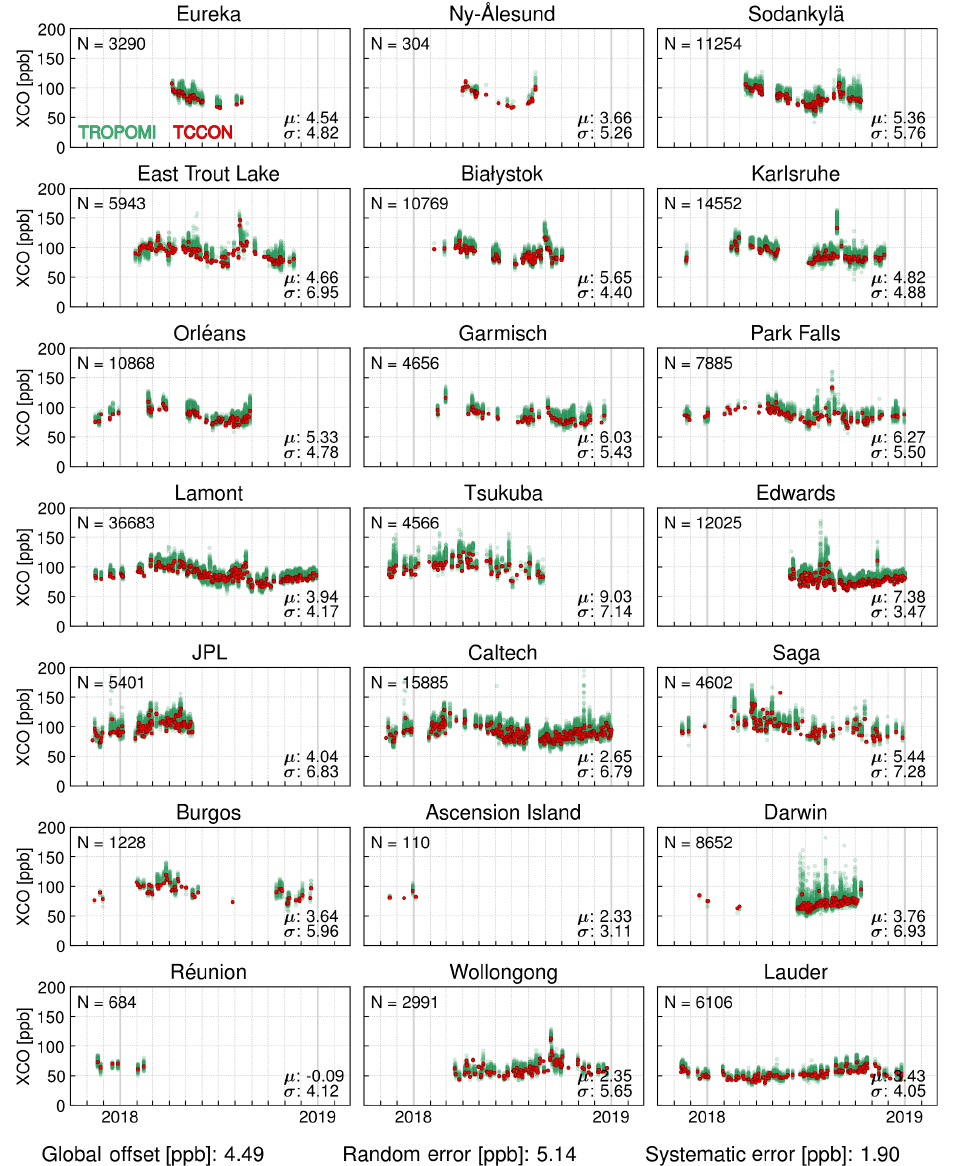
Figure 10. Comparison of the TROPOMI/WFMD v1.2 XCO time series (green) with ground-based measurements from the TCCON (red). For each site, N is the number of collocations, µ corresponds to the mean bias, and σ to the scatter of the satellite data relative to TCCON in parts per billion; σ is estimated from Huber’s Proposal-2 M-estimator. The global offset is defined as the mean of the local offsets at the individual sites, the random error is the global scatter of the differences to TCCON after subtraction of the respective regional biases, and the systematic error is the standard deviation of the µ at the individual